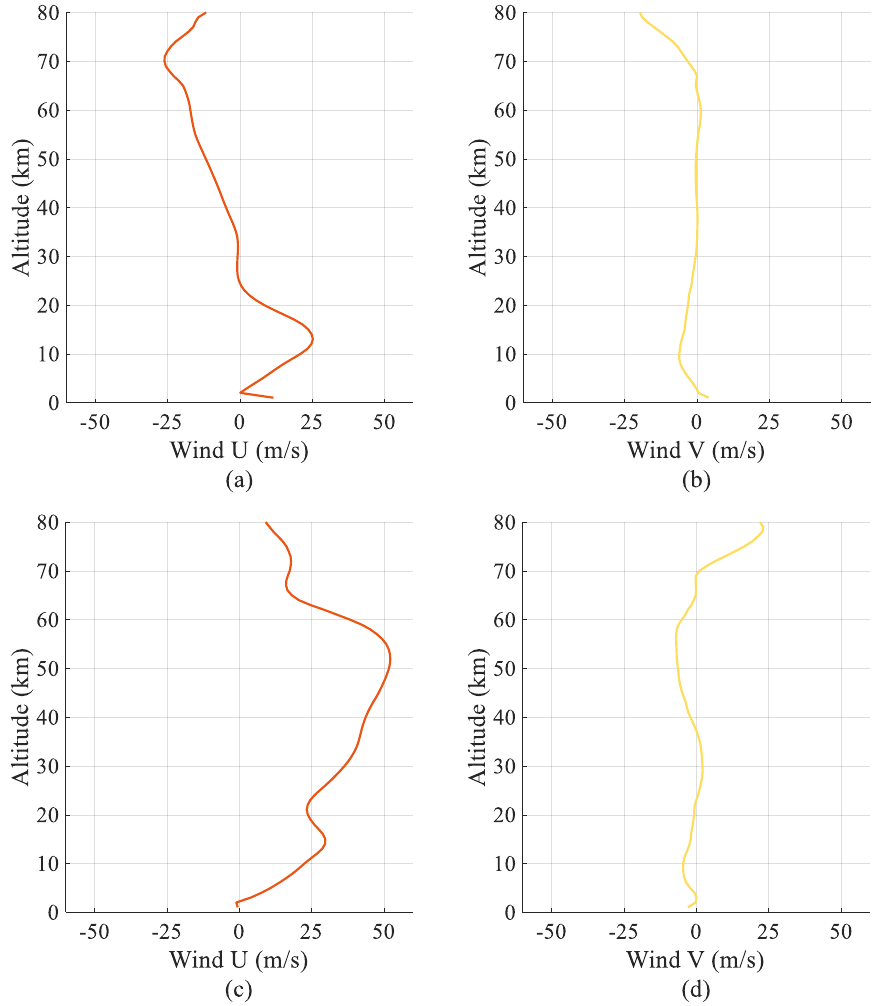
Figure 4. The average horizontal wind profiles of SD – WACCM between 0 – 80 km altitudes corre- sponding to the lidar data in spring – summer ( a , b ) and in autumn – winter ( c , d ). Within the observation range, the results from Jiuquan Station show that the vertical profiles of GWPED turn at 61 km and 65 km in spring – summer and autumn – winter, re- spectively. This finding means that AGWs are more seriously dissipated in the upper stratosphere and lower mesosphere, near the energy-conserved wave propagation above the turning point, and that the feature has no apparent seasonal dependence. Other stud- ies have also been reported, in addition to the mid-latitude regions close to Jiuquan Sta- tion: The study of the Delaware Observatory (42.9° N, 81.4° W) in Canada indicated that the GWPED is obviously lost in the upper stratosphere [28]. The study of 45 – 90 km above Logan, Utah (41.74° N, 111.81° W) showed that AGWs are close to adiabatic growth rate